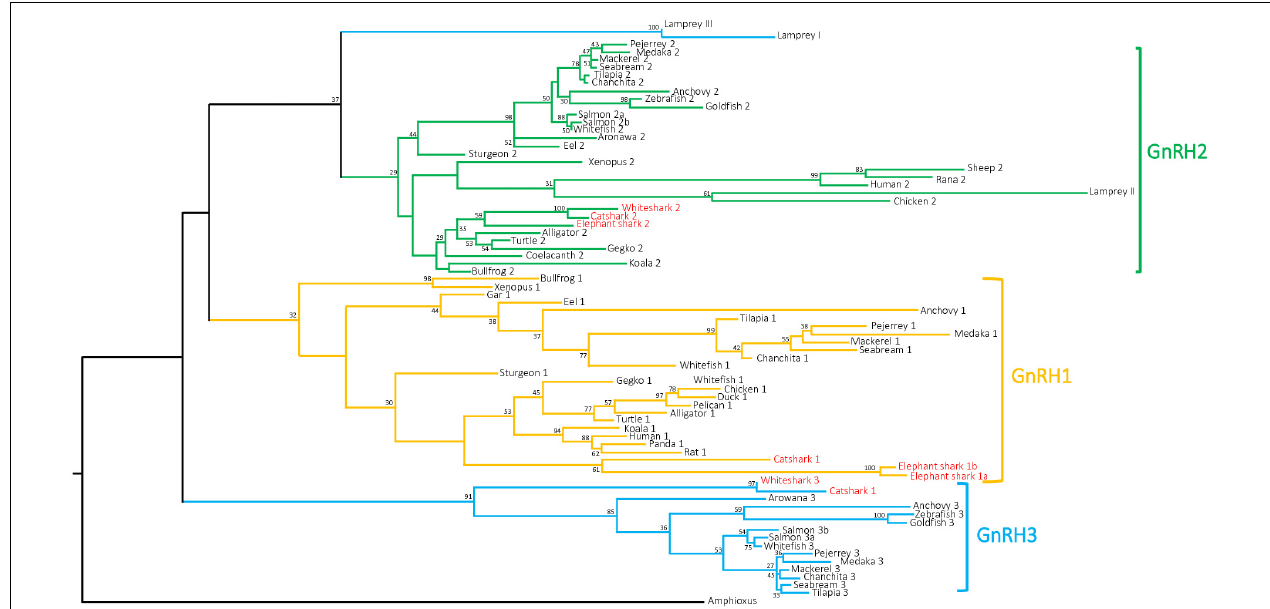
FIGURE 3 | Phylogenetic tree of vertebrate GnRH precursor sequences. Phylogenetic analysis of 73 vertebrate GnRH amino acid sequences was performed using Maximal Likelihood, with 1,000 bootstrap replicates. The number shown at each branch node indicates in percentage the bootstrap value. Only values above 25% are indicated. The tree is rooted with a non-vertebrate chordate (Amphioxus) GnRH sequence used as an outgroup. Sequence references and alignment are given in Supplementary Data Sheets S1 , S2 ,